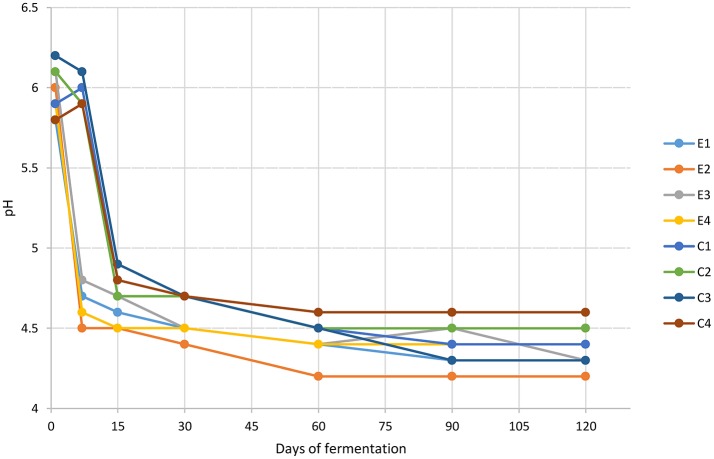
Changes in pH throughout the fermentation of Nocellara Etnea experimental and control samples.